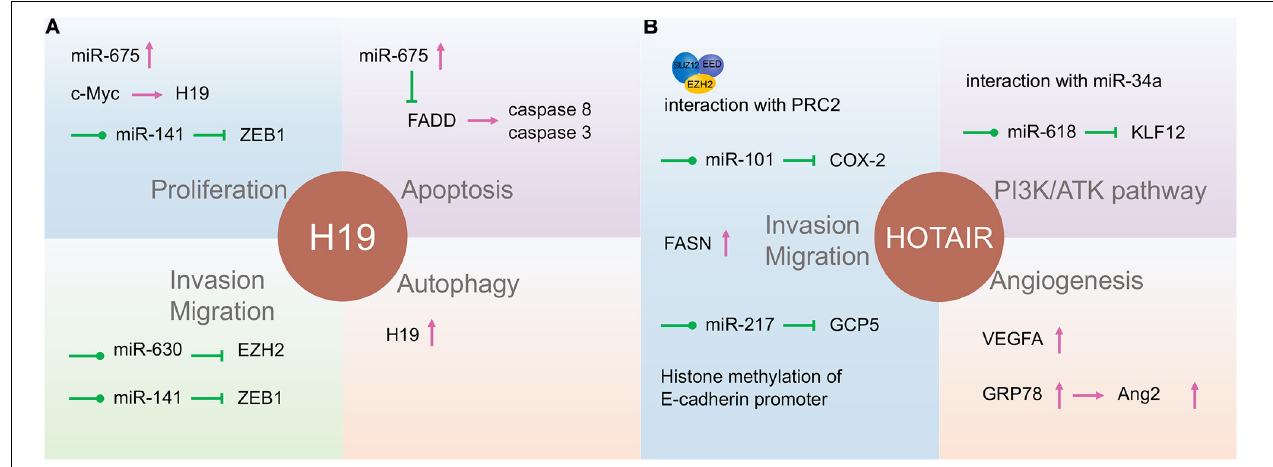
FIGURE 3 | The function of long non-coding RNAs (lncRNAs) H19 and HOTAIR in gastric cancer and nasopharyngeal carcinoma. H19 (A) and HOTAIR (B) are involved in almost all tumor processes, and HOTAIR is more closely associated with tumor progression. They participate in the tumor processes through direct action, adsorption of microRNA (miRNA), or some currently unknown way to regulate gene expression.